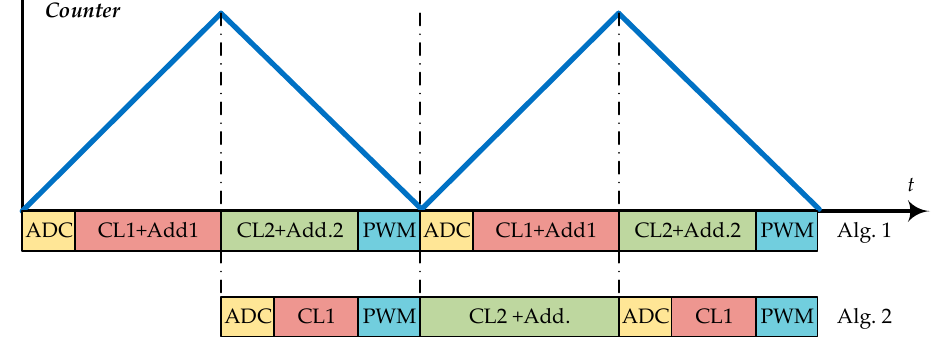
Figure 7. Execution of a control algorithm in microprocessor for reducing the time delay in CL1.